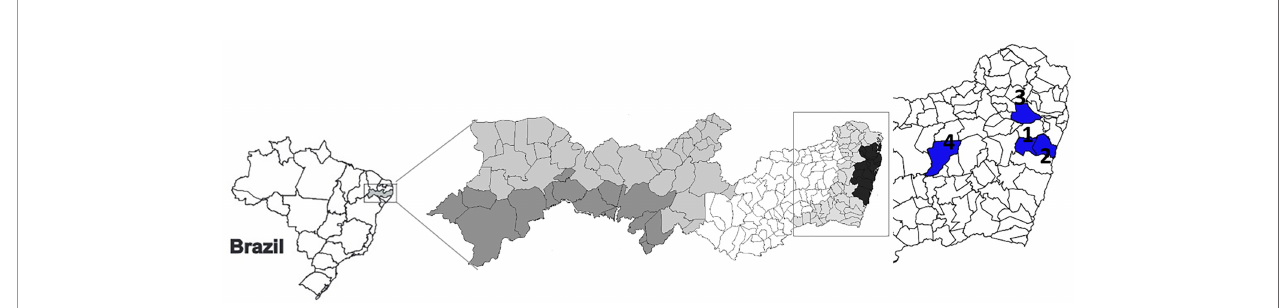
FIGURE 1 | Cartographical representation of the State of Pernambuco, Northeastern Brazil. Regions in blue indicate Moreno (1), Jaboatão (2), Paudalho (3), and Bezerros (4)